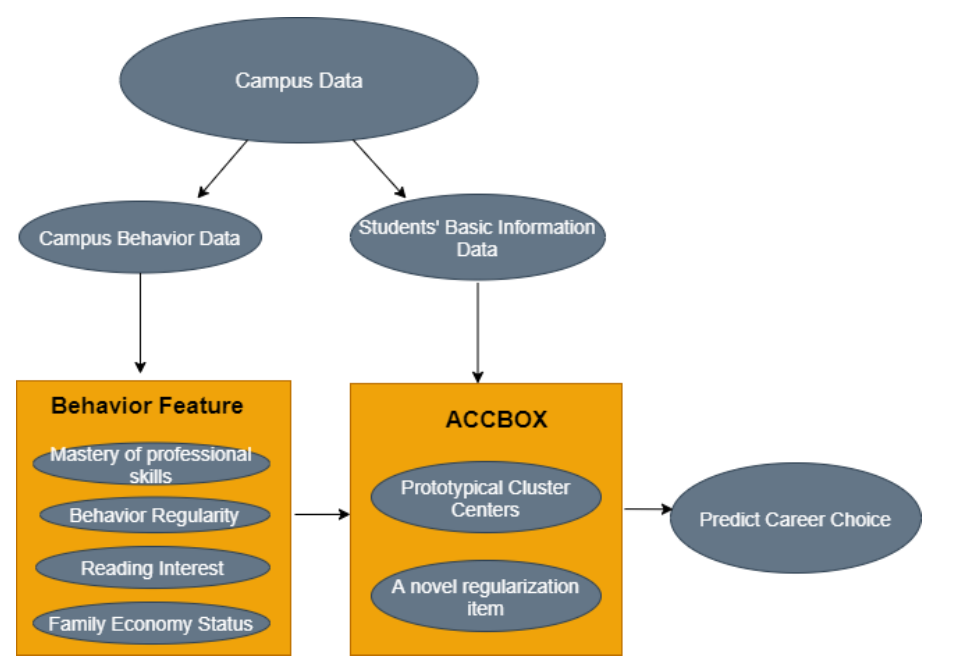
Figure 1. Framework of the proposed Approach Cluster Centers Based On XGBOOST (ACCBOX)